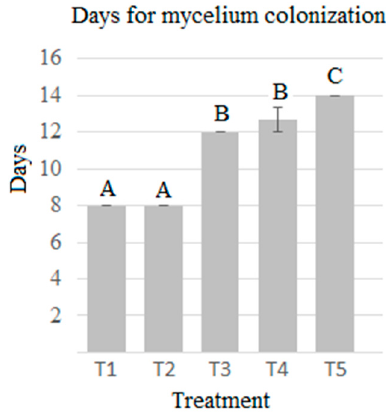
Figure 1. Colonization in P. djamor over the five different treatments. The bars indicate the mean of each experiment in triplicate with SE Different letters indicate significant difference (T-Student p ≤